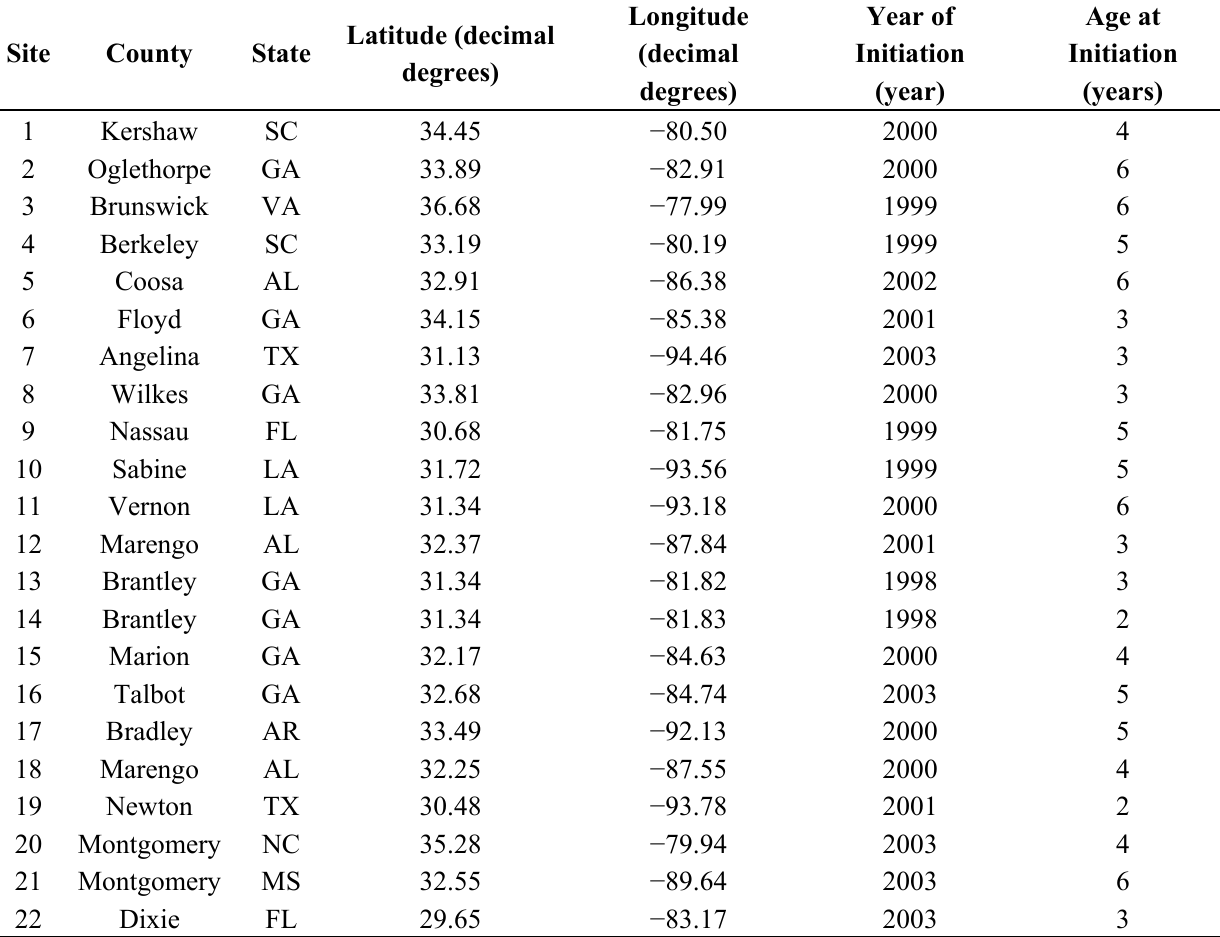
Table 1. Location, age and year of study initiation for the sites examined in this study.